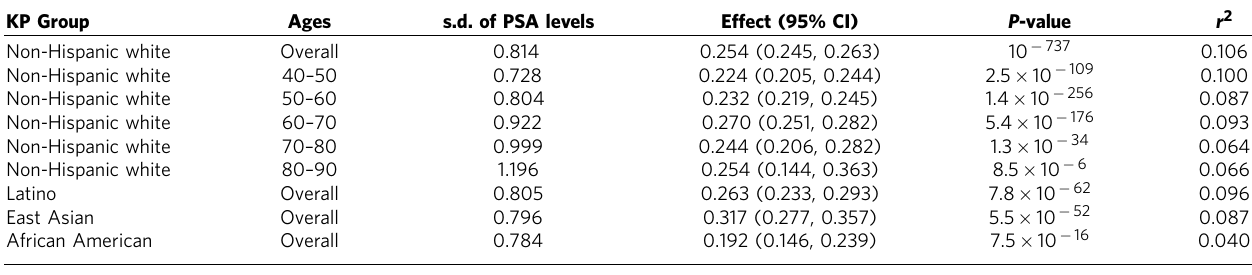
Table 4 | SNP risk score effects on PSA levels and variance explained ( r 2